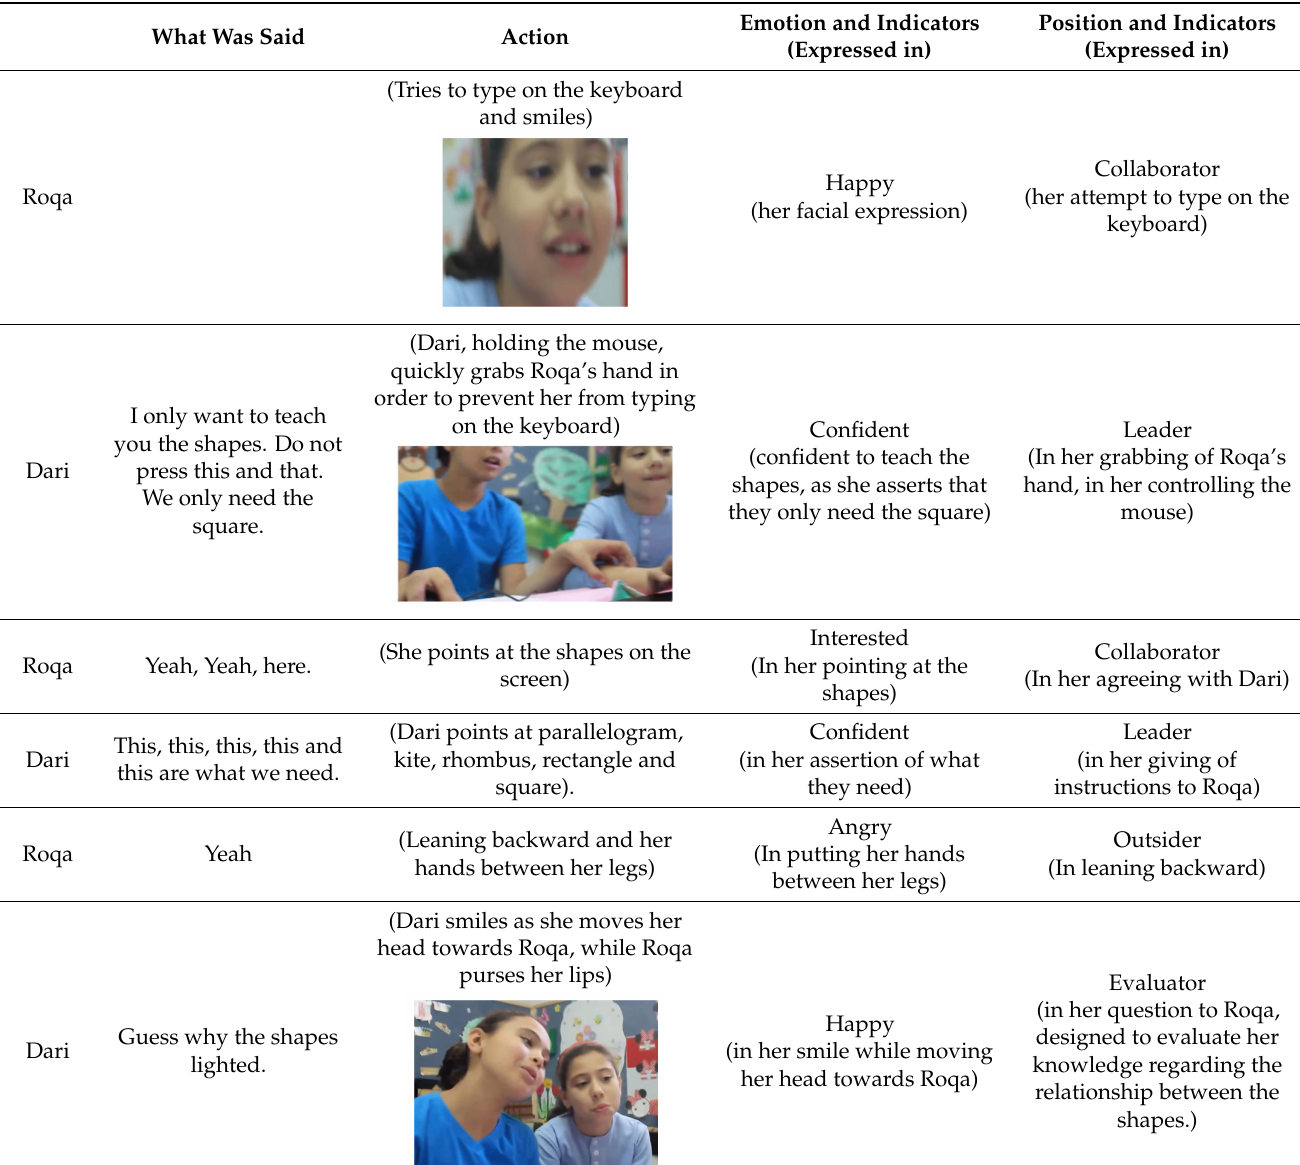
Table 2. Coding emotions and positioning in an